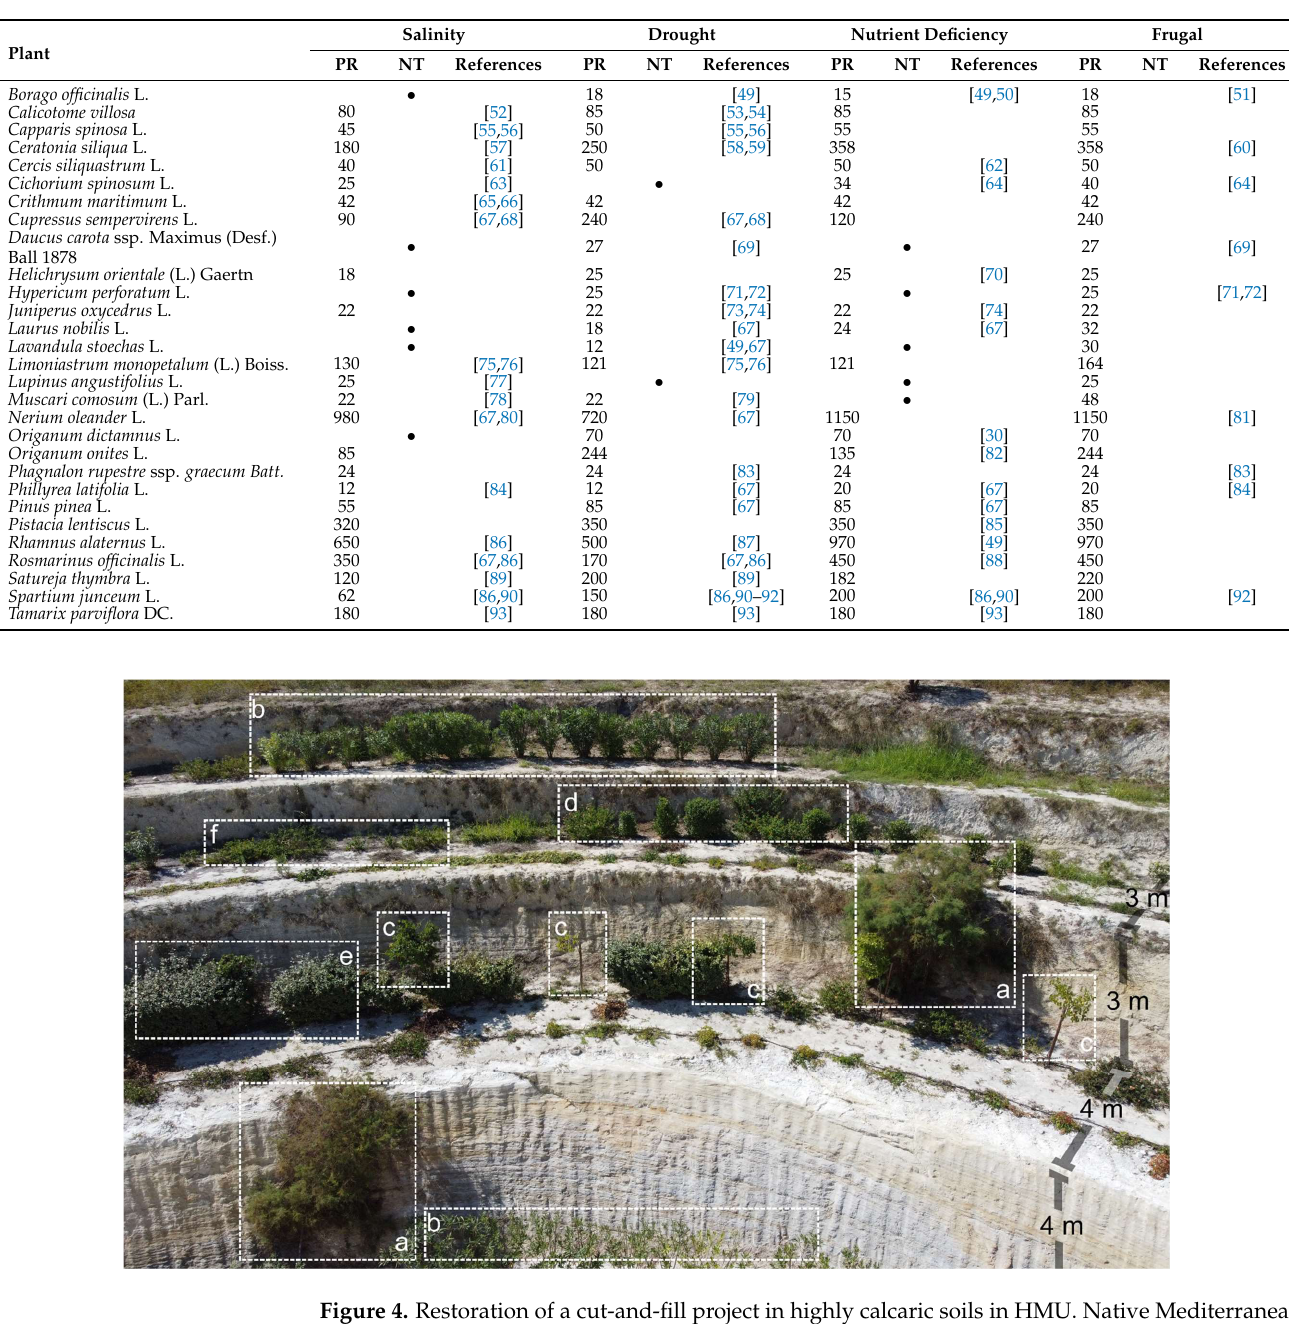
Table 2. Tolerance of native plants of Crete to abiotic stress drivers. PR: number of samples assessed in the present research, NT: black dots indicate that plant has not tested in the literature or the present study. The number of plants varies in some species according to the needs of the green space.